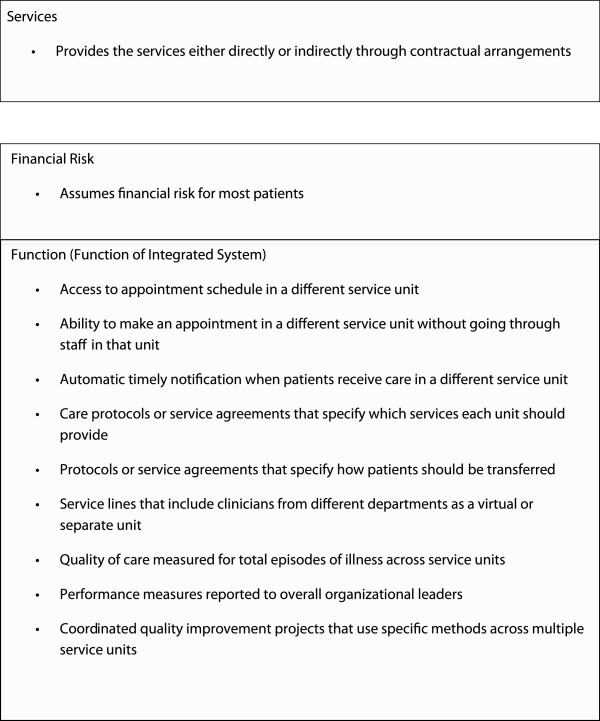
The PPC-RS included an integration scale that measured structure, functions, and financial risk. Total integration score was calculated as the mean of these 3 domains, with possible scores of 0 to 100, with a higher score indicating better service integration. Adapted from Solberg et al. 2009 [9].